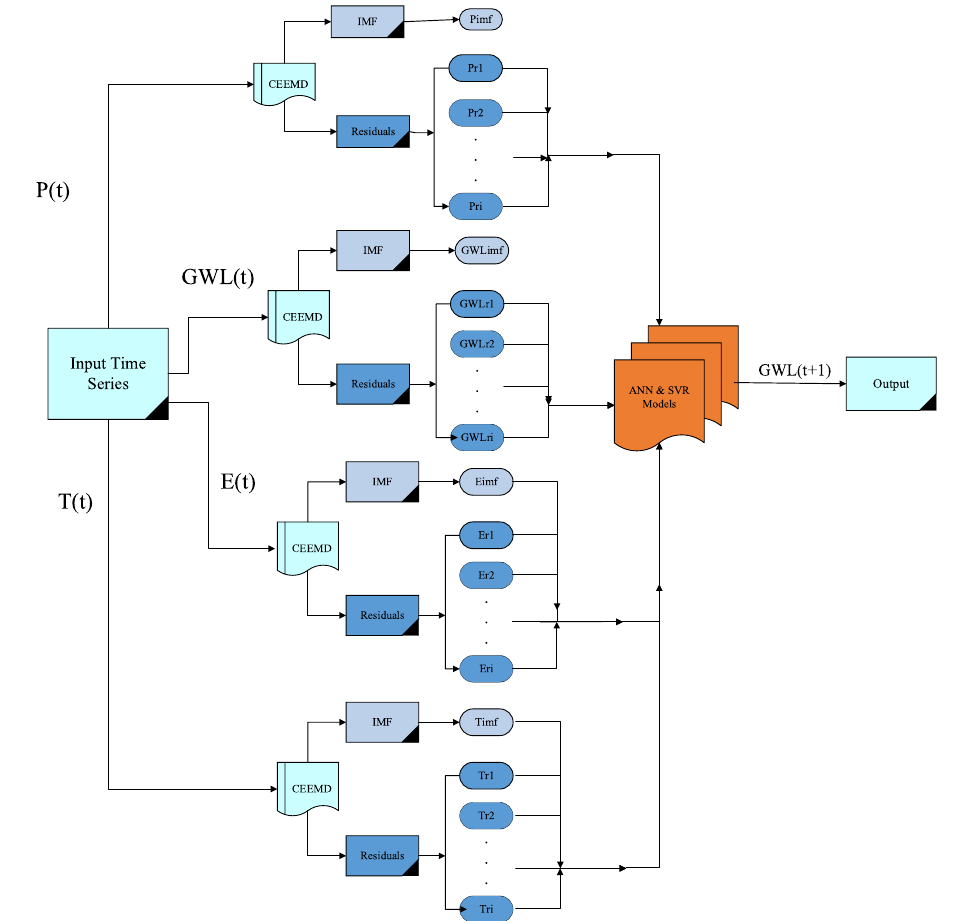
Fig. 6 Schematic diagram of the CEEMD-ANN and CEEMD- SVR models